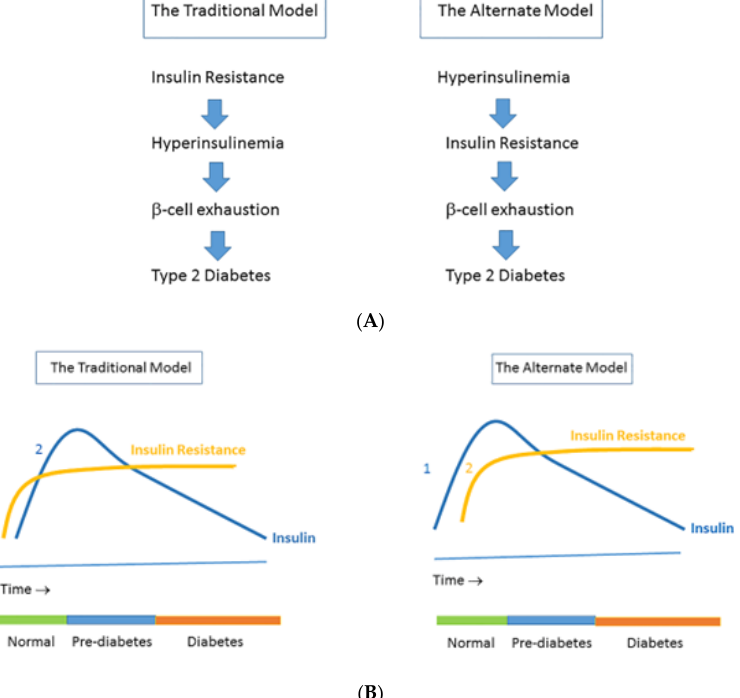
Figure 1. ( A ) The traditional model vs. the alternate model of the pathogenesis of insulin resistance. The traditional model (which is a widely held view) posits that insulin resistance leads to hyperin- sulinemia, which in time is followed by β -cell dysfunction ( left ). In the traditional model, insulin resistance (1) precedes hyperinsulinemia (2), which may be followed by β -cell exhaustion and finally frank type 2 diabetes. ( B ) In the alternate model, hypersecretion of insulin and the resulting hyperin- sulinemia (1) primarily cause insulin resistance (2), which may be followed by β -cell exhaustion and finally frank type 2 diabetes ( right ). Note that in the alternate model hyperinsulinemia is already present when there is still a normal glucose tolerance. Reproduced from